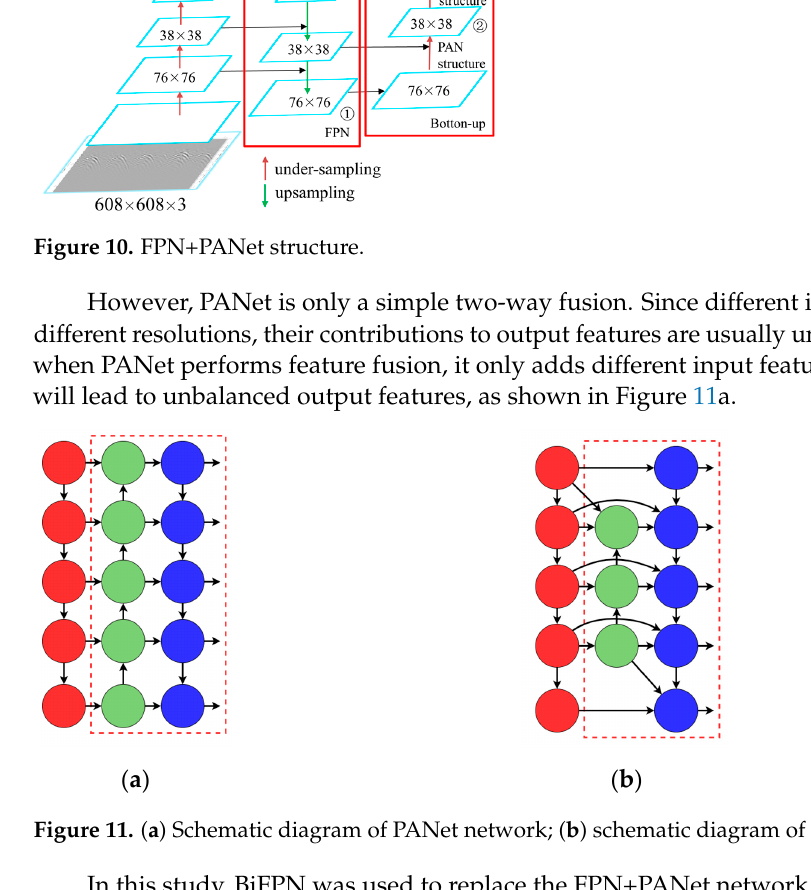
Figure 9. ( a ) Single feature layer structure; ( b ) FPN structure.